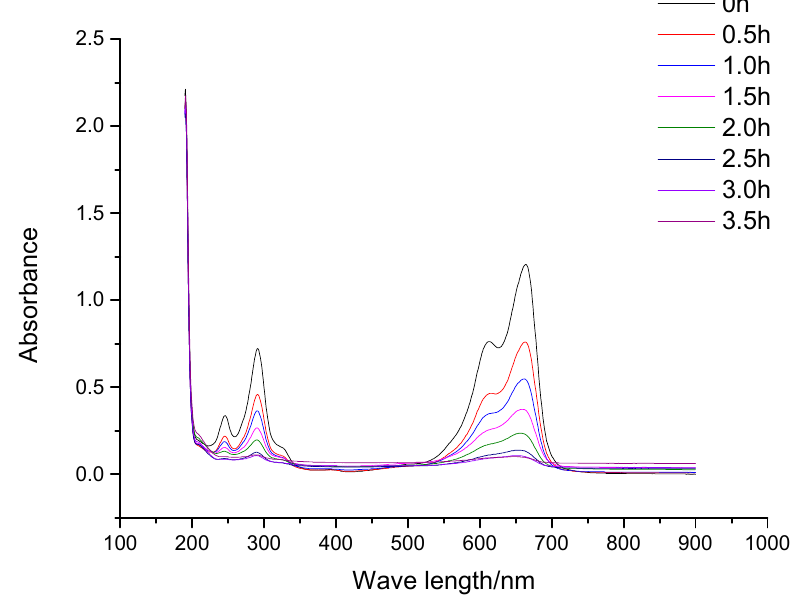
Figure 10. UV-visible light full-wave scanning results of MB synthetic wastewater treated by composite photocatalyst for different periods.